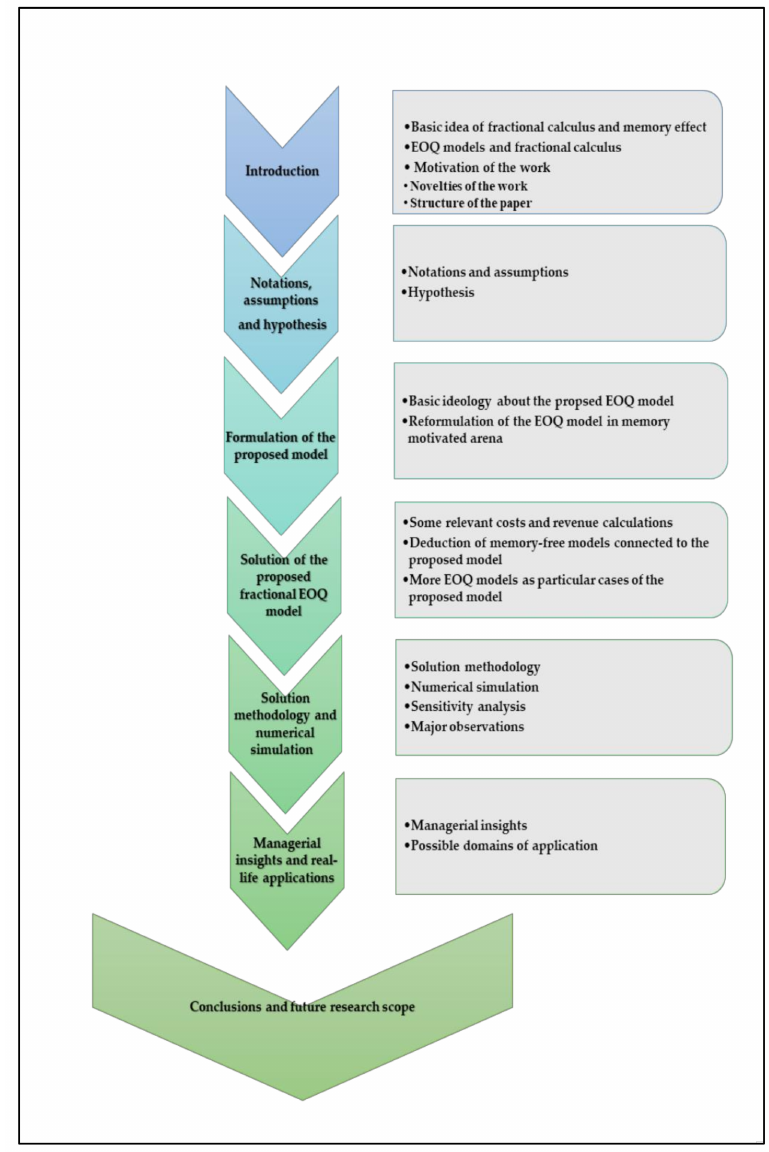
Figure 1. Visual representation of the construction of the present paper with different sections and